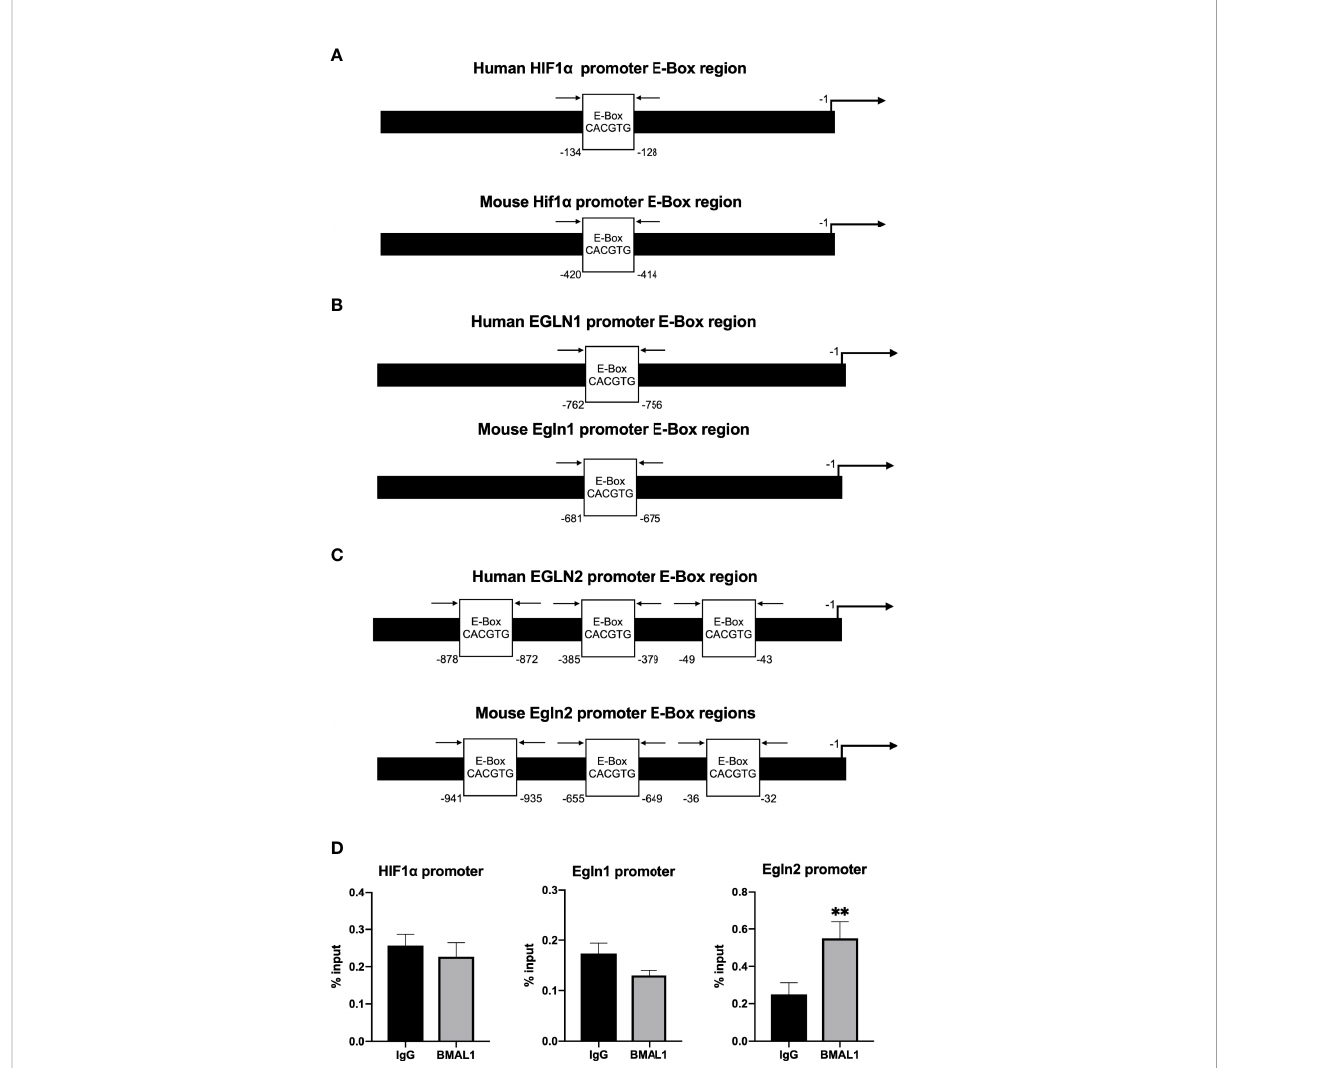
FIGURE 7 ChIP-qPCR assays of BMAL1/CLOCK on HIF1 a and Egln1/2 promoters in podocytes (MPC5). (A) Human HIF1 a and mouse Hif1 a promoter both contain one E-box. (B) Human PHD2 (gene EGLN1 ) and mouse PHD2 (gene Egln1 ) promoter both contain one E-box. (C) Human PHD1 (gene EGLN2 ) and mouse PHD1 (gene Egln2 ) promoter both contain three E-boxes. (D) Enrichment of BMAL1 was evaluated by quantitative PCR of immunoprecipitated DNA compared with input DNA (% of input). Immunoglobulin G (IgG) was used as a negative control. Values represent mean ± SEM. Differences were determined using two-tailed Student t-test.